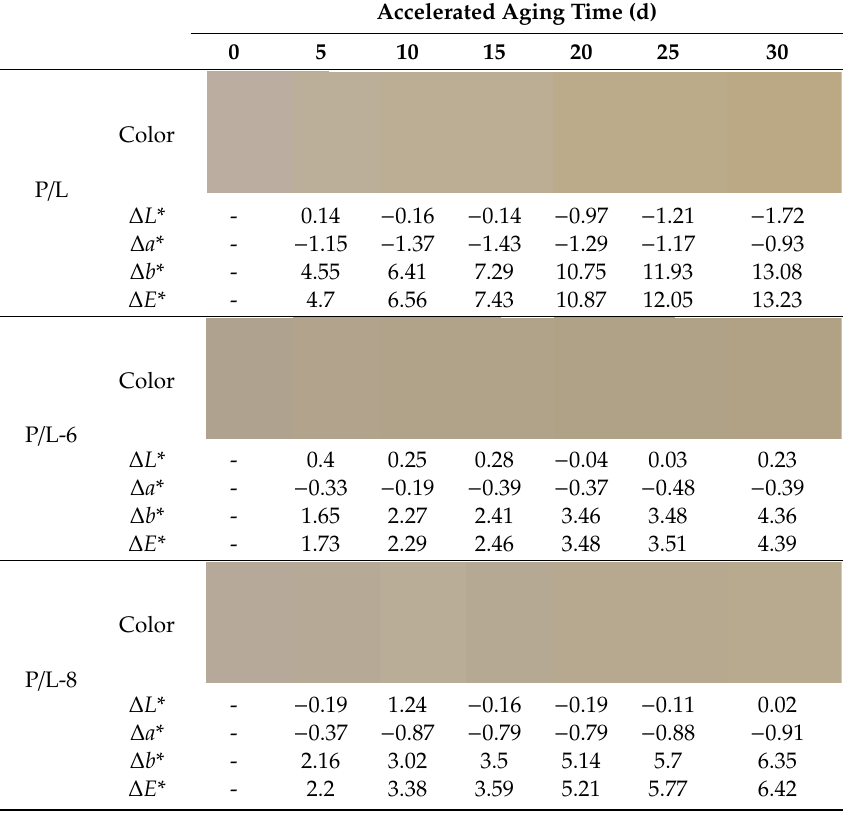
Figure 3. L *, a *, and b * values of samples before and after accelerated aging: ( a ) L *; ( b ) a *; and ( c ) b *.